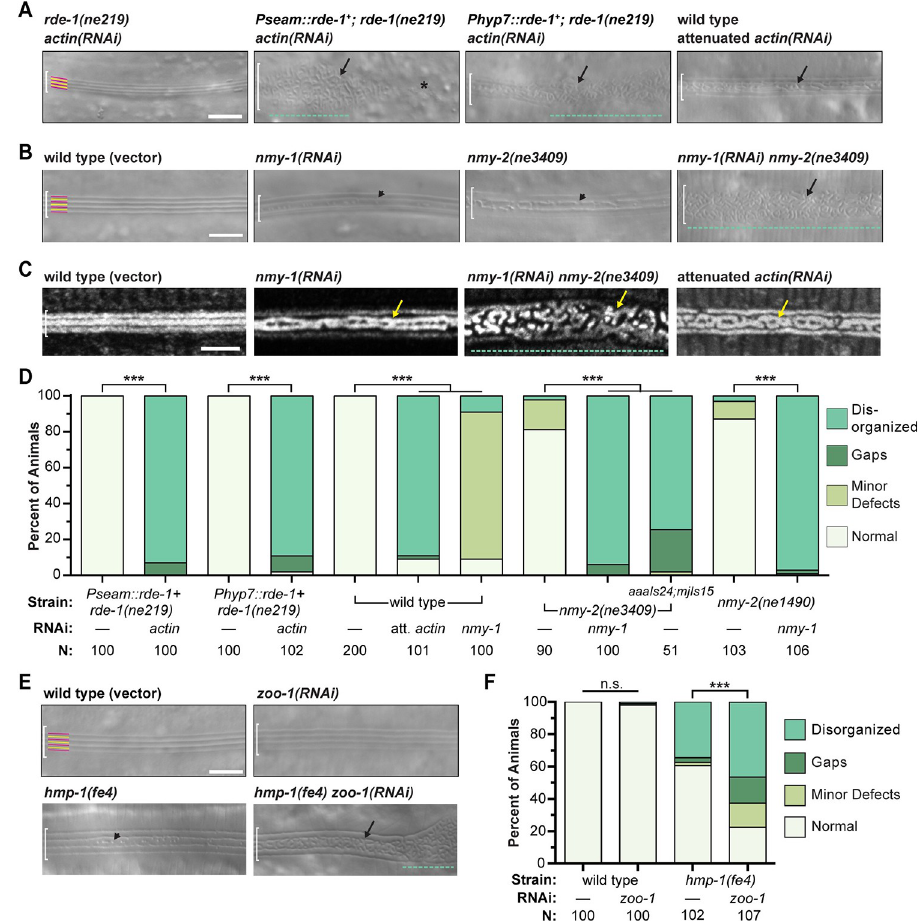
Fig 2. Knockdown of actin, NM II, or AJ components results in alae disorganization. (A) Tissue-specific and whole animal actin knockdowns (strains JK537, ARF281, ARF330, ARF408, N2, 25˚C). Pseam is the promoter of egl-18 (previously known as elt-5 ) [37]. Phyp7 is the promoter of dpy-7 [38]. (B) NM II mutants and knockdowns (strains WM179, WM180, 25˚C). For both A and B, representative DIC images show structures on the lateral surface of young adults of indicated genotypes. White brackets demarcate the region of interest. Yellow and magenta lines label presumptive ridges and adjacent valleys in normal alae. Arrows point to tortuous sub-structures; arrowheads, minor deformities. Asterisk labels large gap. Green dashed lines label severely disorganized regions with no remaining longitudinal pattern. (C) DiI staining of the cuticle in actin and NM II knockdowns, with symbols as above. (D) Prevalence of deformed alae. Disorganized refers to alae that are fragmented and/or contain mis-oriented or tortuous ridges (arrows, green dashed lines). Gaps are regions > 5 microns wide that lack alae entirely (asterisks). Minor deformities include smaller breaks and divots (arrowheads). Values are weighted averages from two independent trials; N: sample size. ��� P < 0.001 for all pairwise comparisons of prevalence of seemingly normal alae in knockdowns and mock-treated specimens; Fisher’s exact test with Bonferroni’s correction for multiple comparisons. (E-F) AJ mutants or knockdowns (strains N2 and PE97, 25˚C), and prevalence of deformed alae, as above. ��� P < 0.001. Scale bars: 5 μ